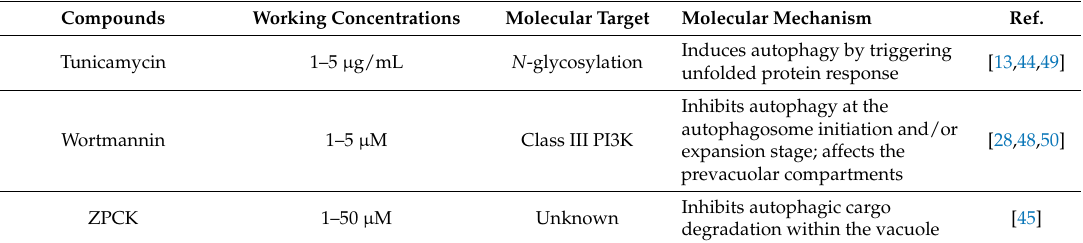
Protocol 5: The “concanamycin